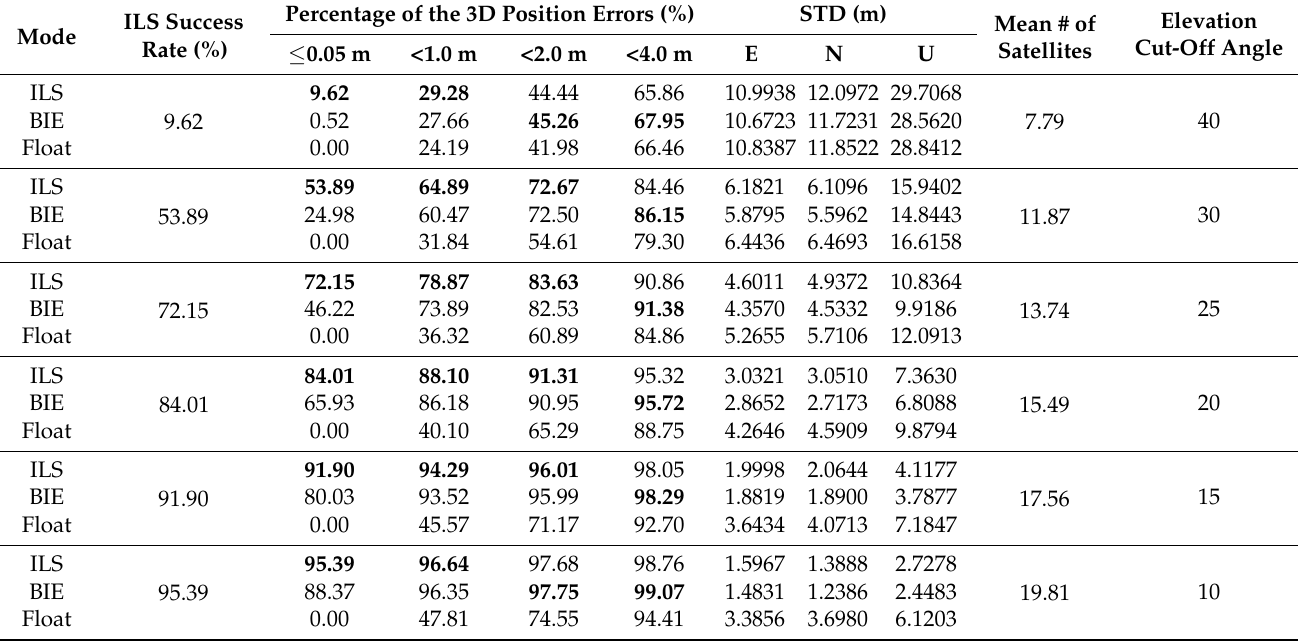
Table 3. Empirical STDs of the ILS, BIE, and float solutions for dual-frequency and instantaneous RTK using GP4 smartphones, based on 6 h observations for a short-baseline internal antenna experiment (see Figure 4). Comparisons of the percentage of the 3D position errors within a range of 0.05 m, 1.0 m, 2.0 m, and 4.0 m are also given. Bold values show the largest percentages for each scenario and